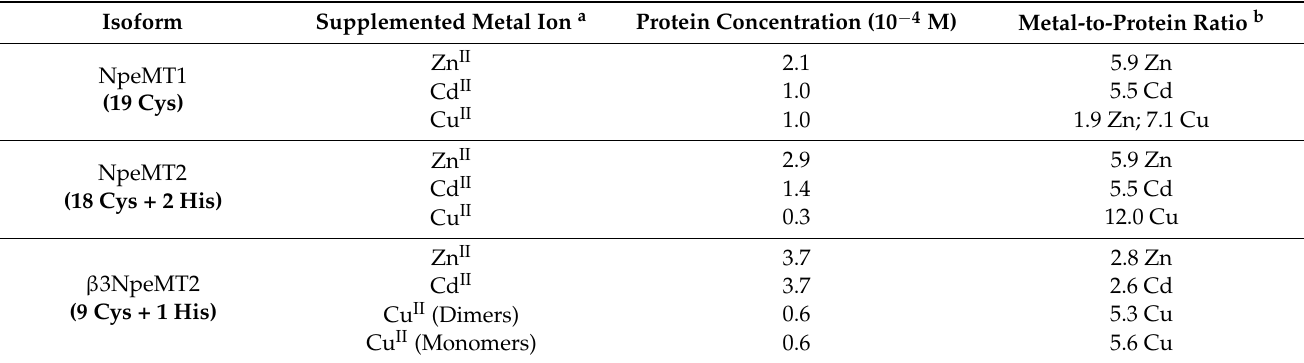
Table 1. Protein concentration and metal-to-protein ratio of the recombinant NpeMT1, NpeMT2, and β 3NpeMT2 purified from Zn II -, Cd II -, and Cu II -enriched E. coli cultures.